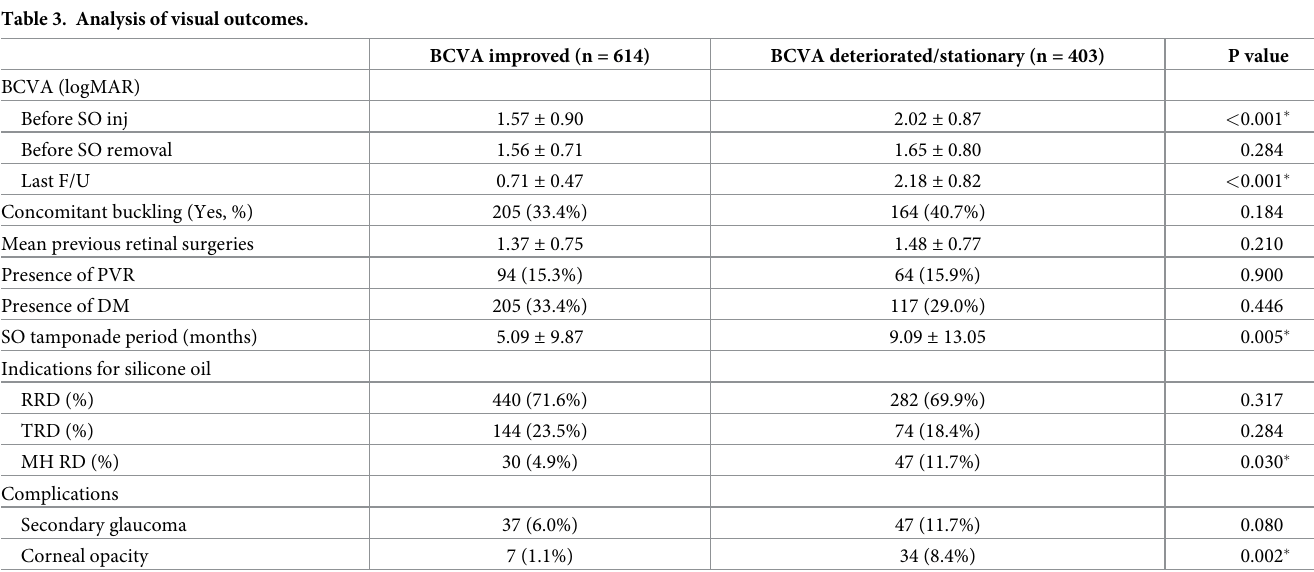
Table 3. Analysis of visual